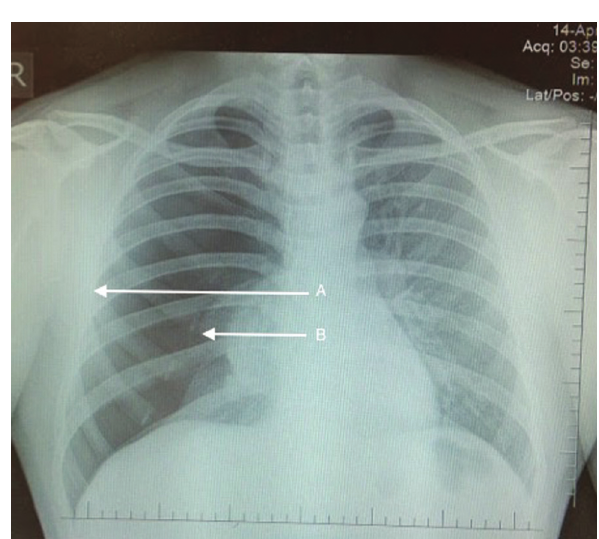
Light index calculated as 100[1 − (lung diameter (A) 3 /hemithorax di- ameter(B) 3